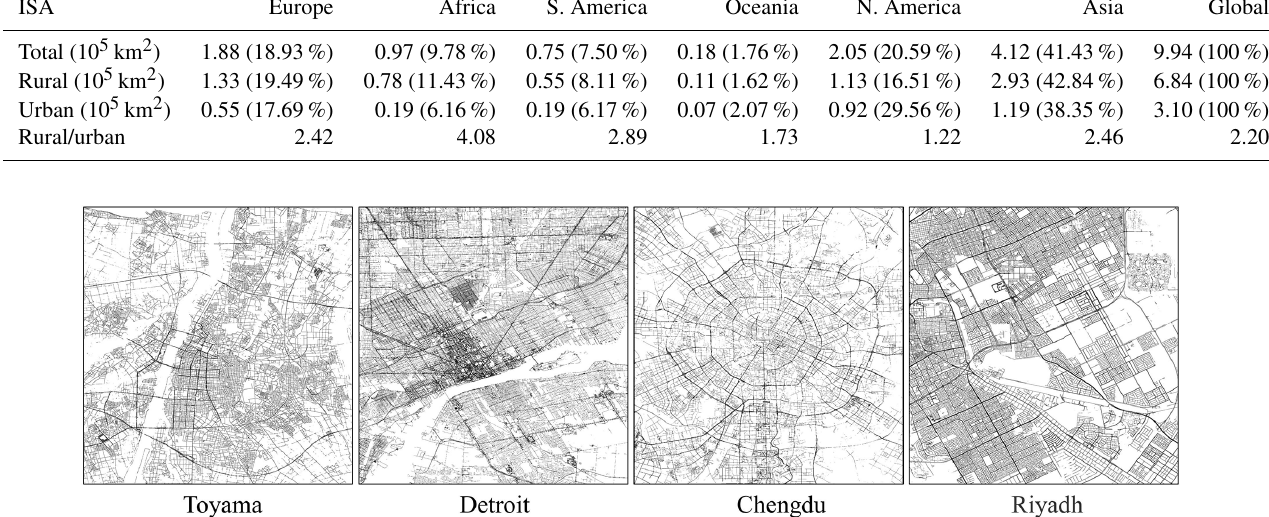
Figure 8. Examples of road area derived from GISA-10m and OSM in Toyama (Japan), Detroit (US), Chengdu (China), and Riyadh (Saudi